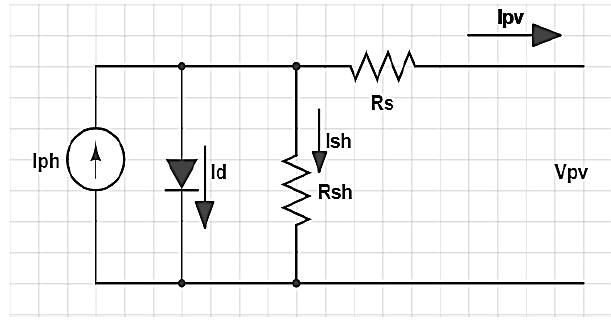
Figure 8. Internal layout of PV cell.